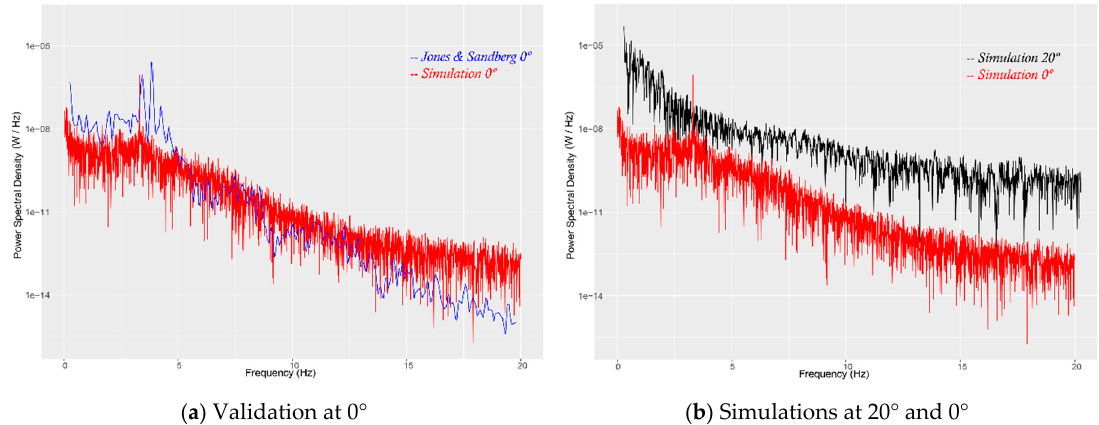
Figure 3. Power spectral density spectra for isolated NACA0012 airfoil at Re = 1 × 105, microphone located at 0.5 m above the mid-chord of the airfoil: ( a ) Validation with DNS data at 0° [38] and ( b ) Black and red curves are our LES + FWH at angle of attack 20°and 0°, respectively.